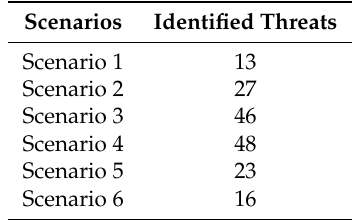
Table 2. Identified threats for each